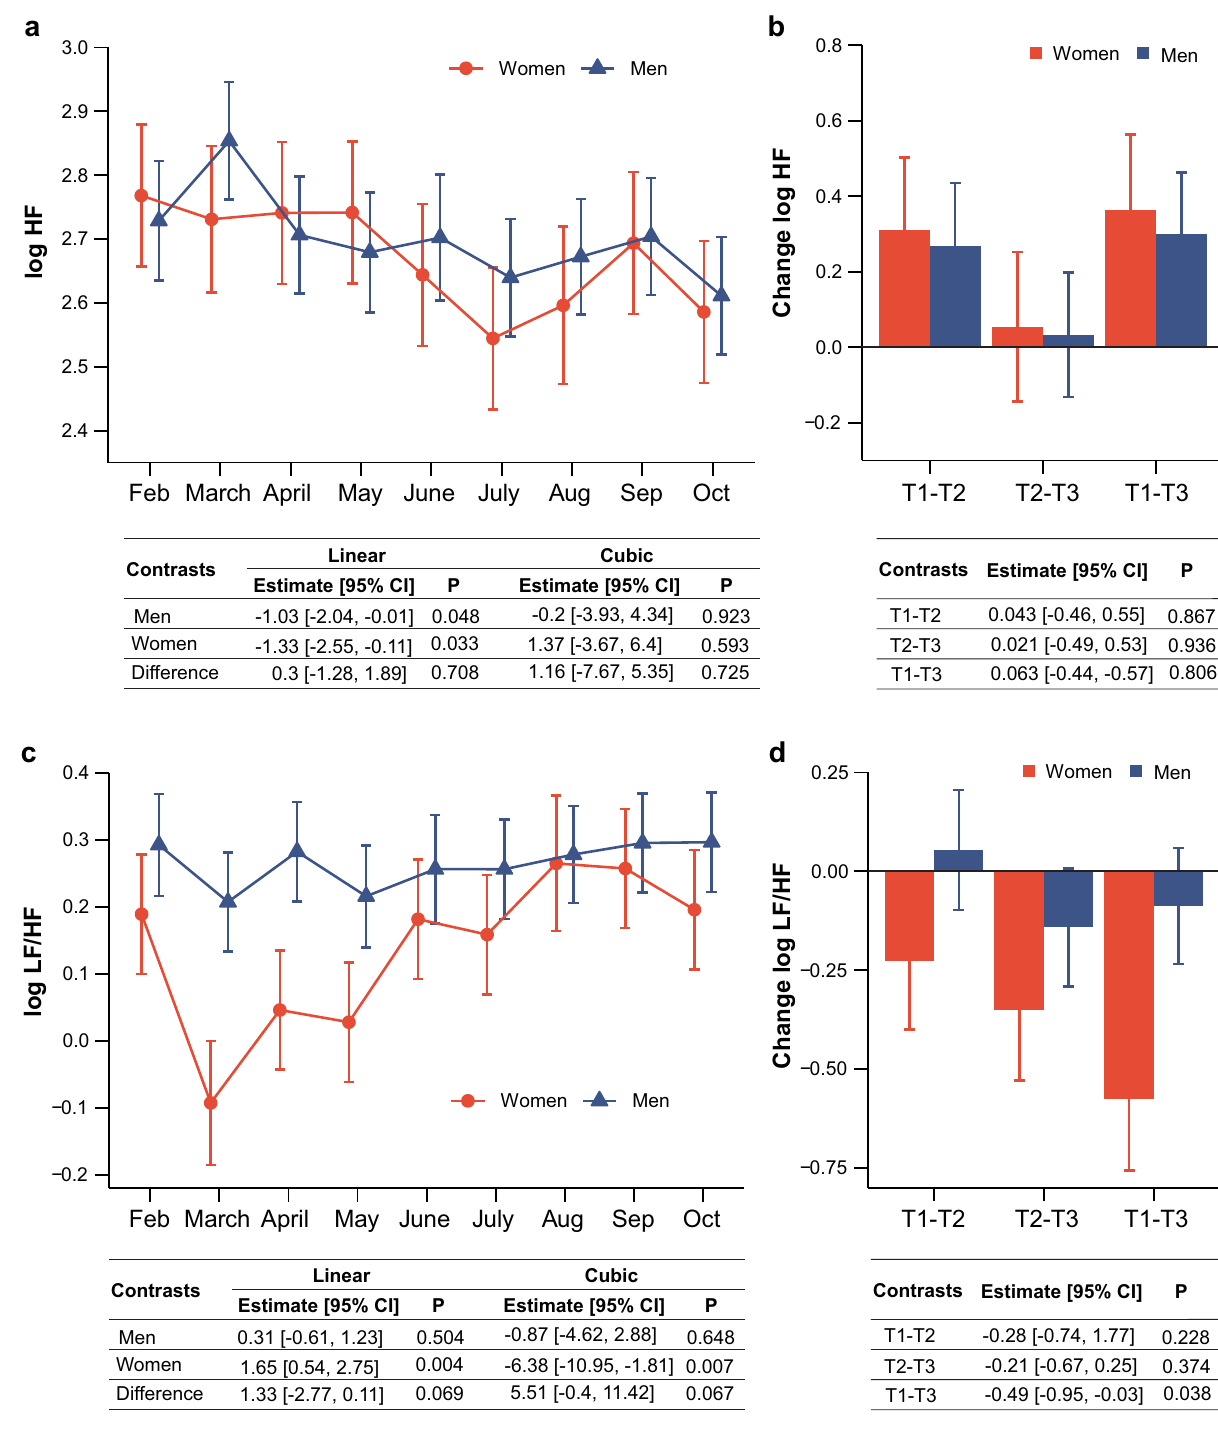
Figure 1. Temporal profiles of log HF ( a ) and log LF/HF ( c ) during Antarctica overwintering in men (blue) and women (red). Data are adjusted means and standard errors. Contrasts show mean effects and 95% CI for linear and cubic trends in men and women and their differences. Detailed polynomial contrast analyses are provided in Table 3. Panel ( b ) and ( d ) show changes between trimesters T1, T2, and T3 for men (blue) and women (red), which were defined as T1: Feb to April; T2: May to July; and T3: Aug to Oct. Contrasts indicate interactions between trimesters and sex, i.e., mean differences between men and women relative to changes in log HF and Log LF/HF from T1 to T2, T2 and T3, and T1 and T3, respectively. Detailed contrasts analyses are reported in Table